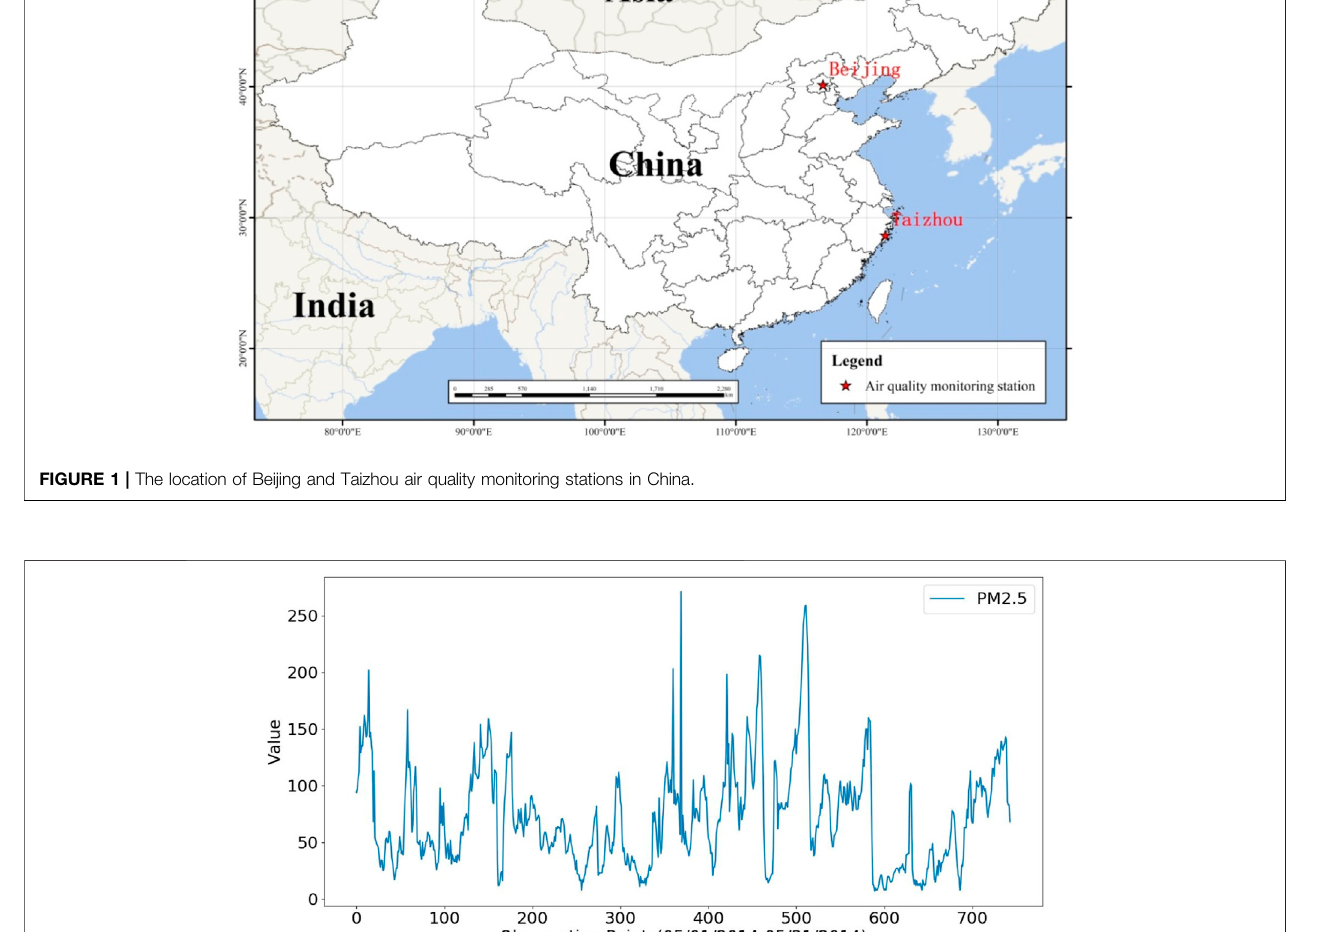
Frontiers in Environmental Science |